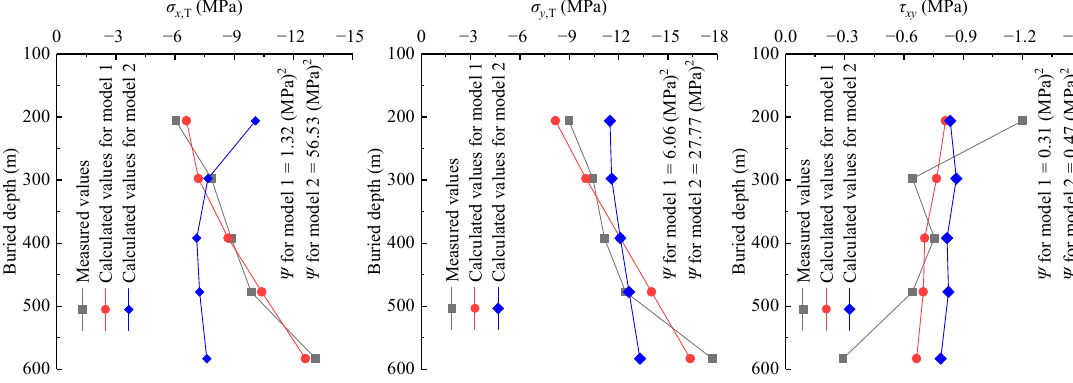
Figure 11. The comparison of in situ stress orientations considering geo-temperature.